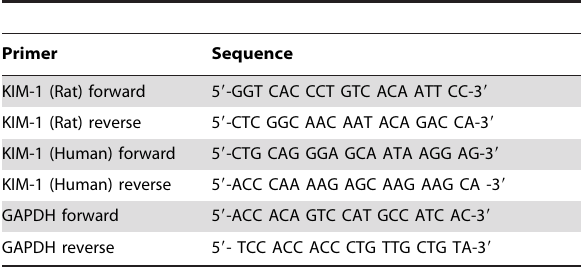
Table 1. Sequences of primers used in RT-PCR.